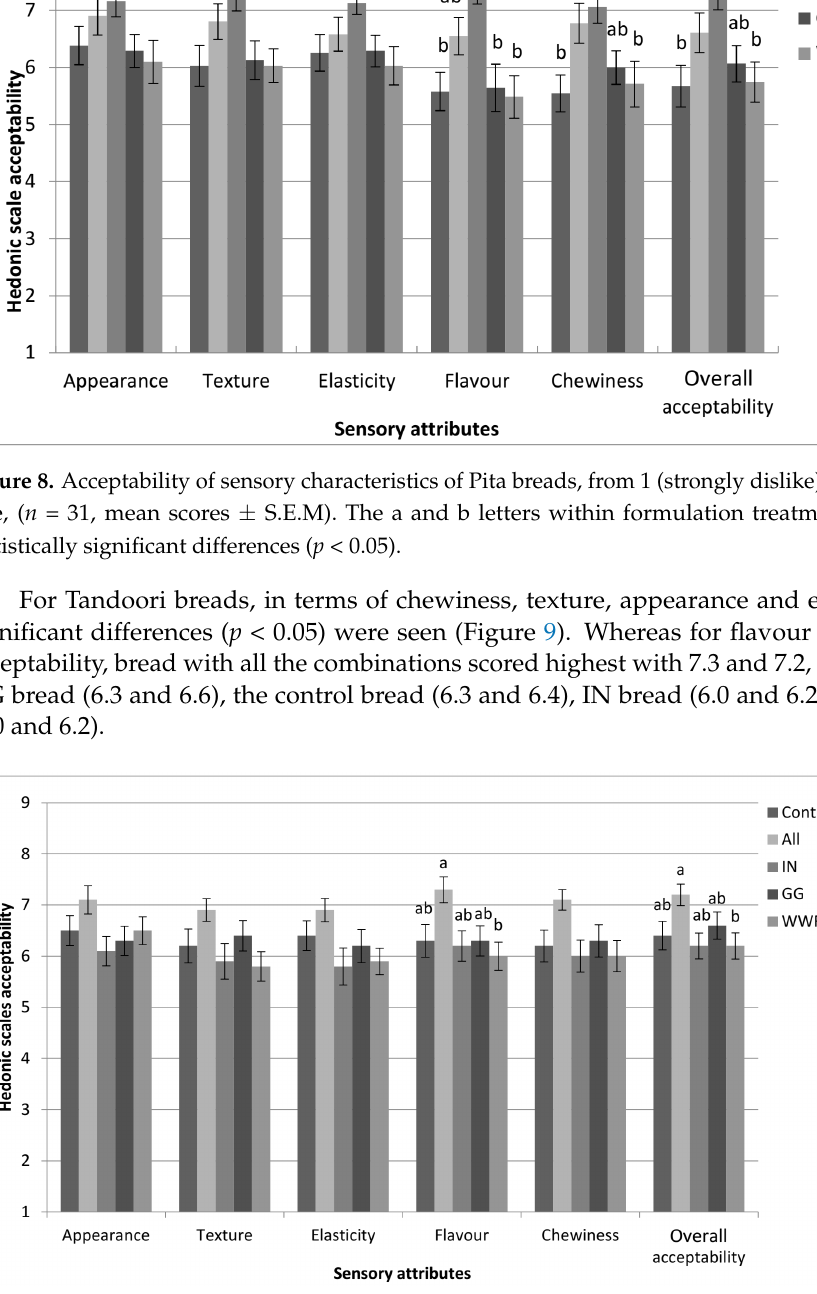
Figure 9. Sensory characteristics of Tandoori breads, from 1 (strongly dislike) to 9 strongly like ( n = 33, mean scores ± S.E.M). The a and b letters at within formulation treatments indicate statistically significant differences ( p <